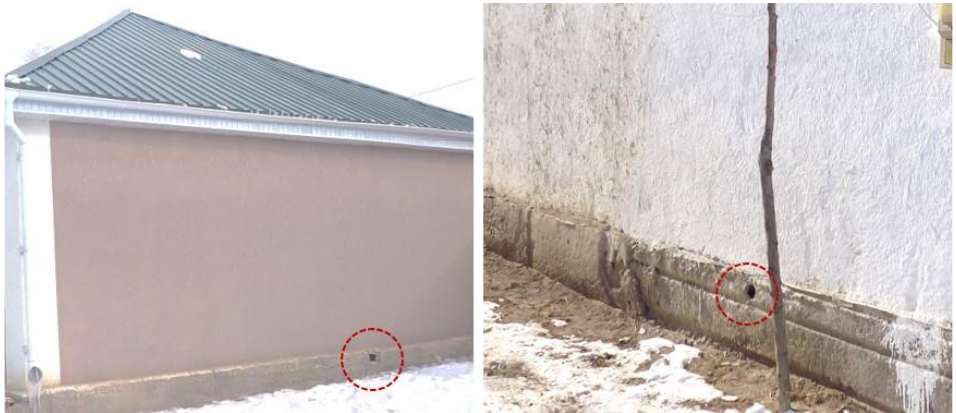
Figure 10. Natural ventilation inlet/outlet to the environment in the floor of rural Kyrgyz